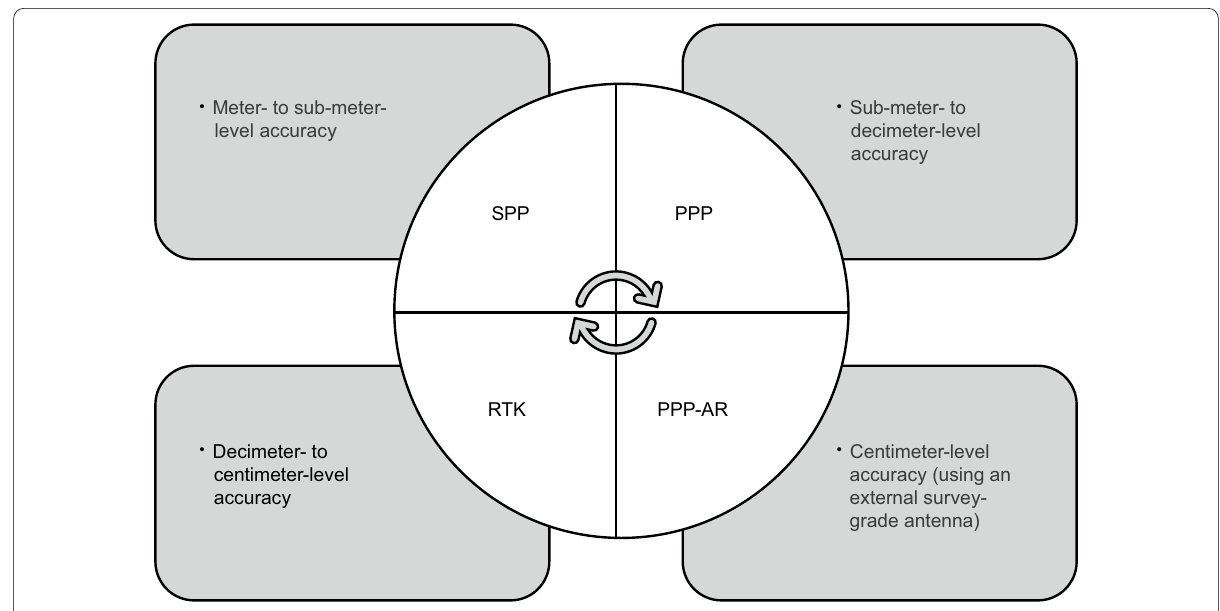
Fig. 12 Summary of achievable smartphone positioning accuracy reported in research